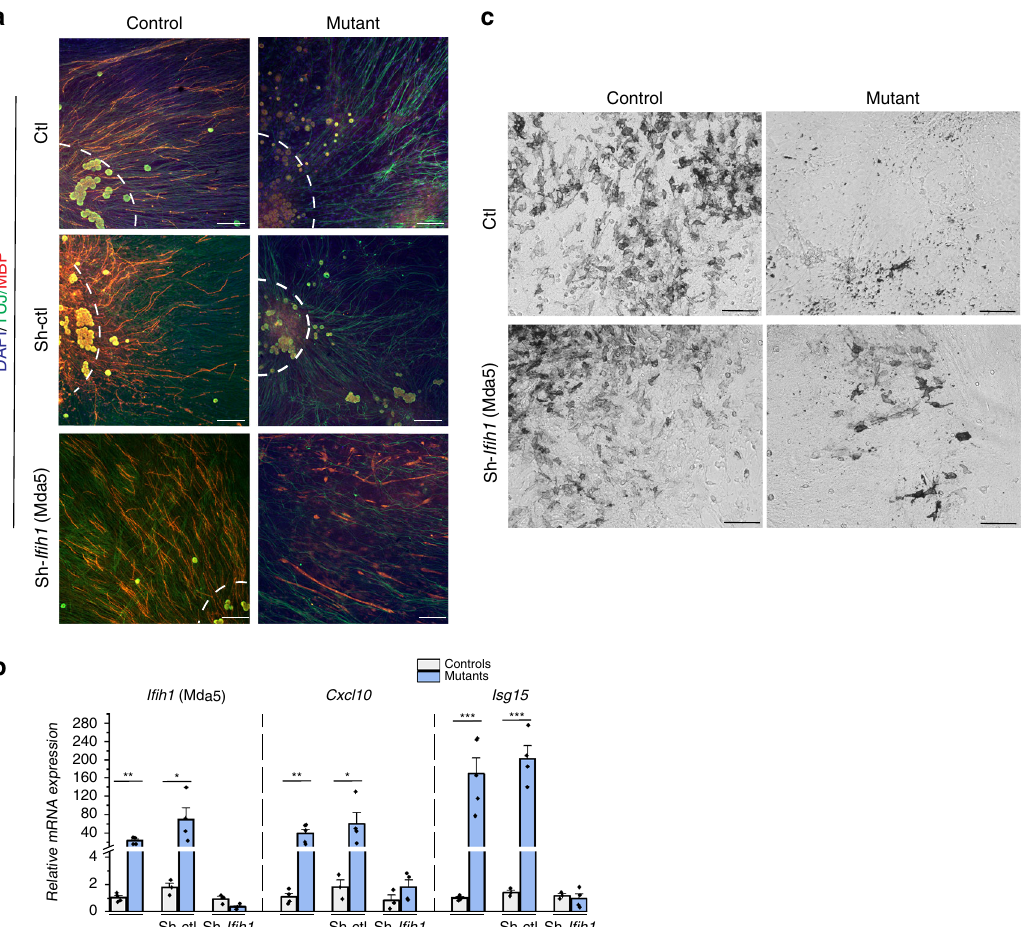
Fig. 7 Shutdown of I fi h1 rescues the SCs and melanocytes defects in Adar1 mutants. a TUJ1 (green)/MBP (red) immunostaining performed on primary cultures of mixed neurons and SCs from dorsal root ganglia (DRG) of control and HtPA-Cre; Adar1 fl / fl mutant embryos at E13.5. Cultures were untransduced (no infection, Ctl) or transduced with lentivirus containing Sh-control (Sh-ctl) or Sh- I fi h1 just before myelination induction. Note the absence of MBP in Adar1 mutants and the restored phenotype upon Sh -I fi h1 transduction. Counterstaining with DAPI (blue) is shown to identify cell density. Scale bar: 12 μ m. b Relative mRNA expression of I fi h1 (Mda5, to show I fi h1 -shRNAs ef fi cacy validation), and two ISGs ( Cxcl10 and Isg15 ) analyzed by RT-qPCR on RNAs extracted from untransduced ( − ) and transduced primary cultures of controls (gray) and mutants (blue). All data represent mean ± SEM. Statistical differences between the groups ( n = 4 controls and n = 4 mutants) were determined using t test (asterisks represent p values: *p < 0.05, **p < 0.01, ***p < 0.001). c Pigmented melanocytes (melanin-producing cells) observed after culture of NC cells issued from trunk region of neural tube of control and Adar1 mutant embryos at E9.5. No discernable differences could be observed between controls and mutants during the fi rst 7 days of culture, but note the reduction of melanin-producing cells in Adar1 mutants ( n = 7) compared to controls ( n = 6) after 21 days of culture. Three days after neural tube explant deposition on fi bronectin, cultures were untransduced (Ctl) or transduced with lentivirus containing Sh- I fi h1 . Note the restored phenotype of mutants upon Sh -I fi h1 transduction ( n = 5). Sh -I fi h1 transduction had no discernable effects on control cultures ( n = 3). Scale bar: 100 μ m. Source data are provided as a source data fi tube explants cultures from E9.5 embryos performed under conditions favoring melanocytes proliferation and differentiation revealed a drastic reduction in the number of melanin-producing melanocytes in mutants compared to controls (Fig. 7c, ctl line, mean ± SEM of 167 ± 42 and 13 ± 12 melanocytes counted in six controls and seven mutants respectively, ***p < 0.001, t test). As for SCs, I fi h1 -ShRNAs infection increased the number of melanin- producing cells in Adar1 mutants (49 ± 12, **p < 0.01; Fig. 7c), suggesting that concomitant deletion of Mda5 at least partially rescue pigmentation defects. In light of these results, the phenotype of Adar1;Mavs 11 and Adar1;I fi h1 double mutants (ref. 45 and D. Stetson, personal communication) was re-interpreted and revealed no pigmentation anomalies in either models, suggesting that pigmentation defects we observed in vitro and in vivo result from a mechanism that is MDA5/MAVS dependent.